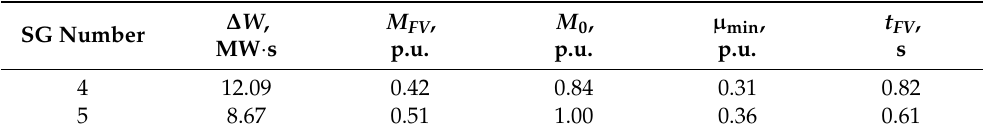
Table 5. The results of the synthesis of the law of TFV SG 4 and 5 with the preventive removal of node